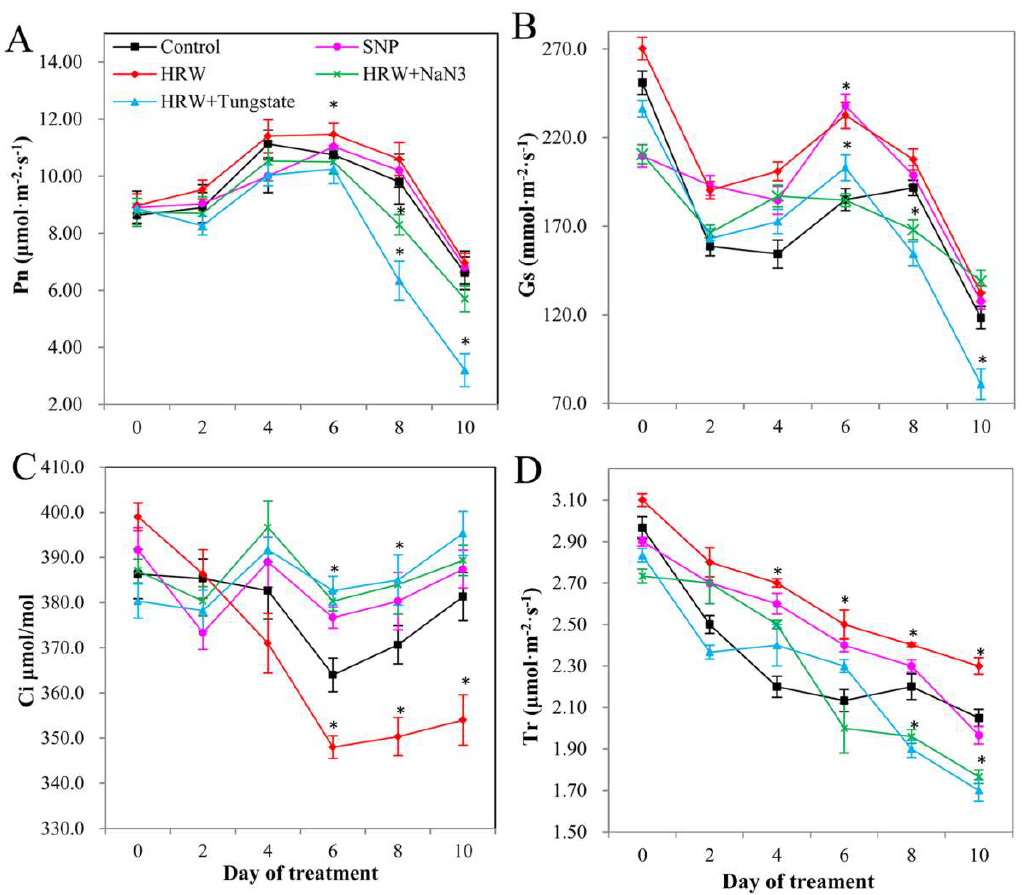
Figure 7. Effects of HRW, SNP, and HRW plus NaN 3 or tungstate on photosynthetic parameters. Values of net photosynthetic rate (Pn) ( A ), stomatal conductance (Gs) ( B ), the intercellular CO 2 concentration (Ci) ( C ), and transpiration rate (Tr) ( D ) are the mean ± SE of three independent experiments with three repeats for each. Asterisks indicate significant difference ( p < 0.05 by Duncan’s multiple range test) compared to the control within the same day.